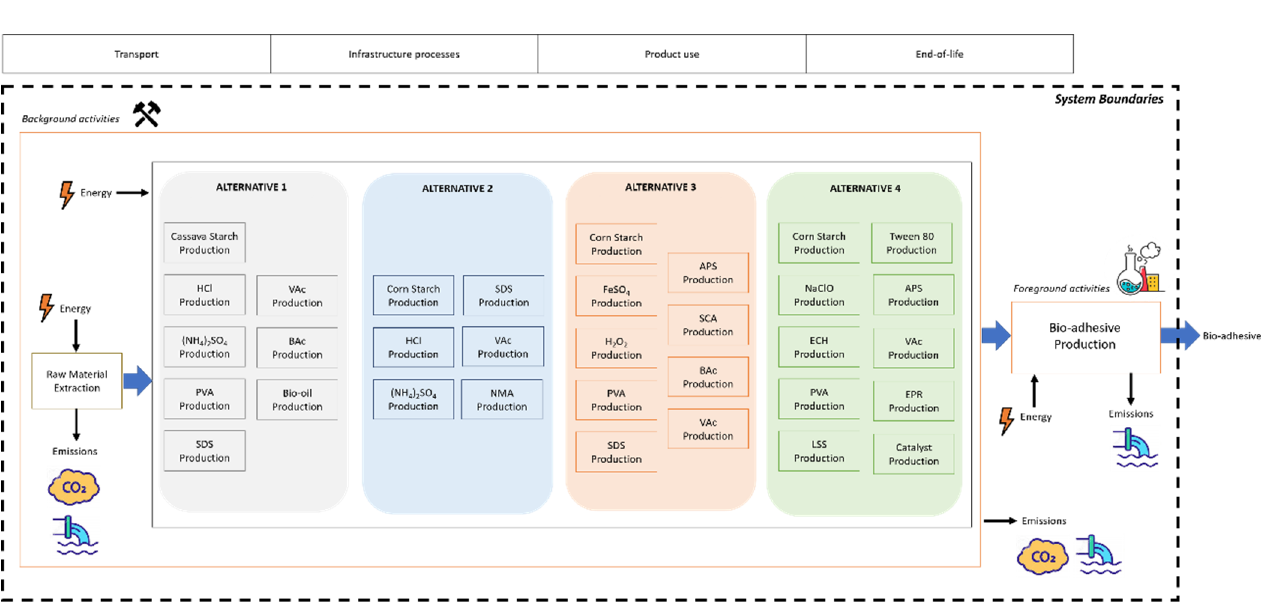
Figure 1. System boundaries of the bioadhesives’ production considered for LCA analysis.